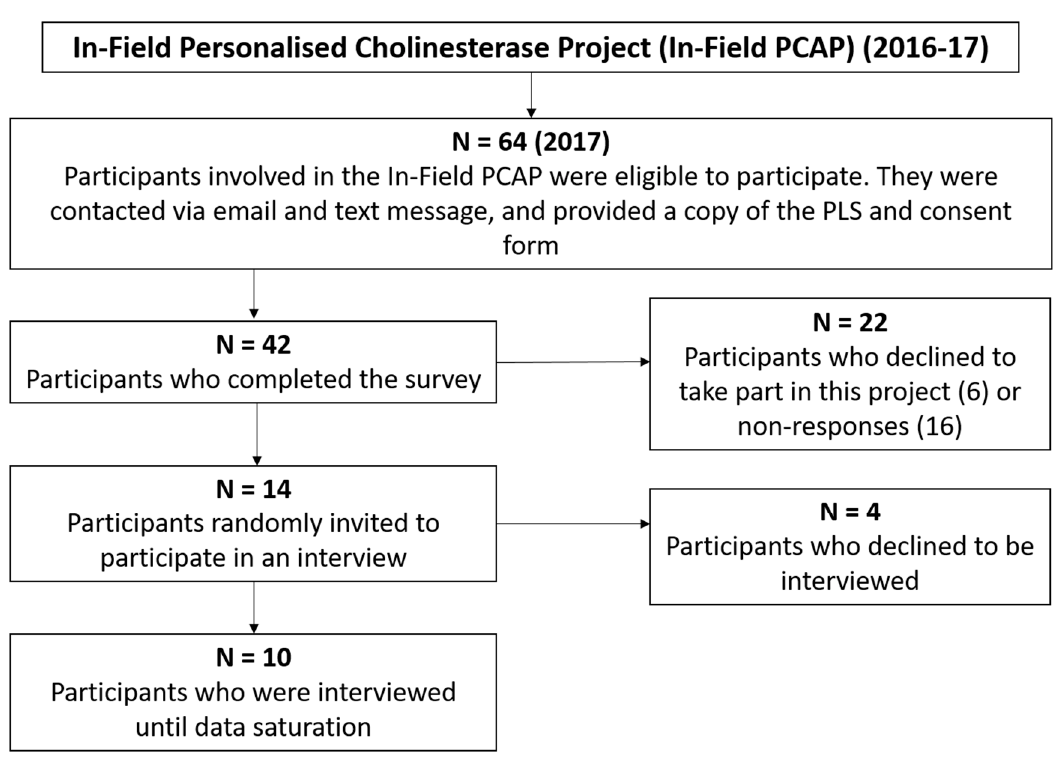
Figure 1. Flow chart of study recruitment.